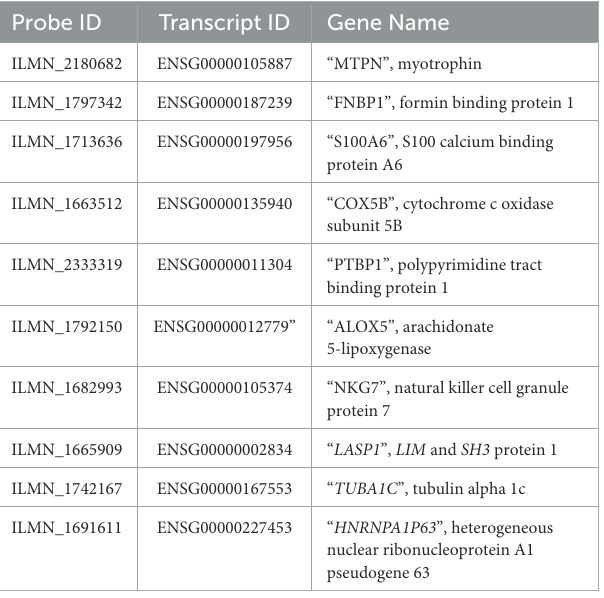
TABLE 3 The 10 top genes/probes identified by the MCC method.